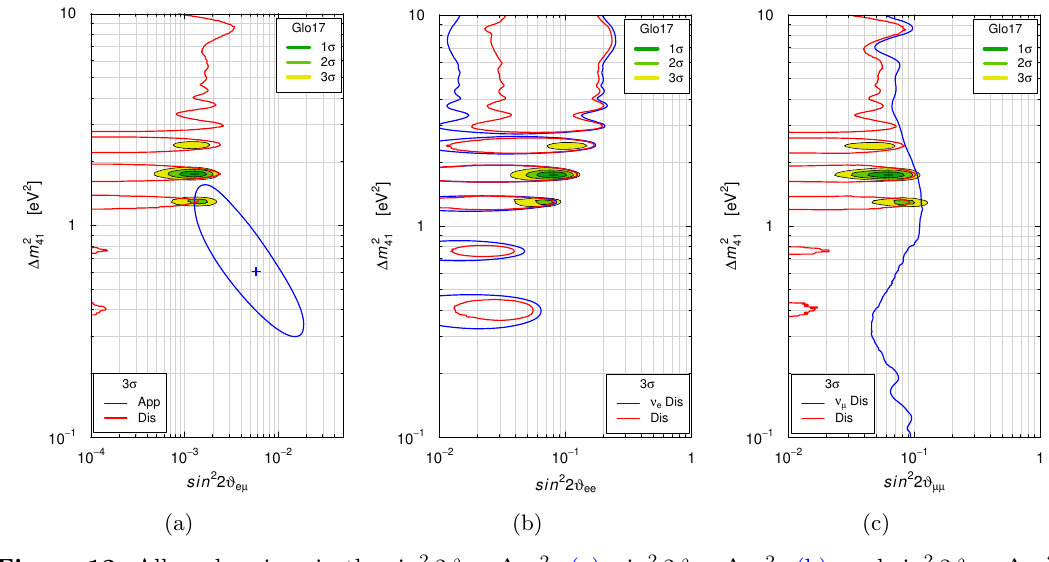
Figure 12 . Allowed regions in the sin 2 2 # e(cid:22) {(cid:1) m 2 (c), planes obtained in the 3+1 global (cid:12)t \Glo17" of all SBL data. There is a comparison with the 3 (cid:27) allowed regions obtained from ( (cid:0) ) (cid:23) (cid:22) ! ( (cid:0) ) (cid:23) e SBL appearance data (App) and the 3 (cid:27) constraints obtained from ( (cid:0) ) (cid:23) e SBL disappearance data ( (cid:23) e Dis), ( (cid:0) ) (cid:23) (cid:22) SBL disappearance data ( (cid:23) (cid:22) Dis) and the combined ( (cid:0) ) (cid:23) e and ( (cid:0) ) (cid:23) (cid:22) SBL disappearance data (Dis). The best-(cid:12)t points of the Glo17 and App (cid:12)ts are indicated by